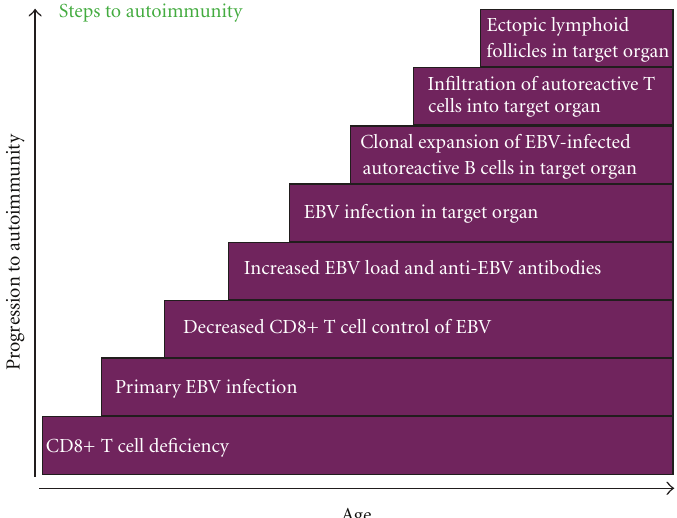
Figure 2: Steps to autoimmunity.